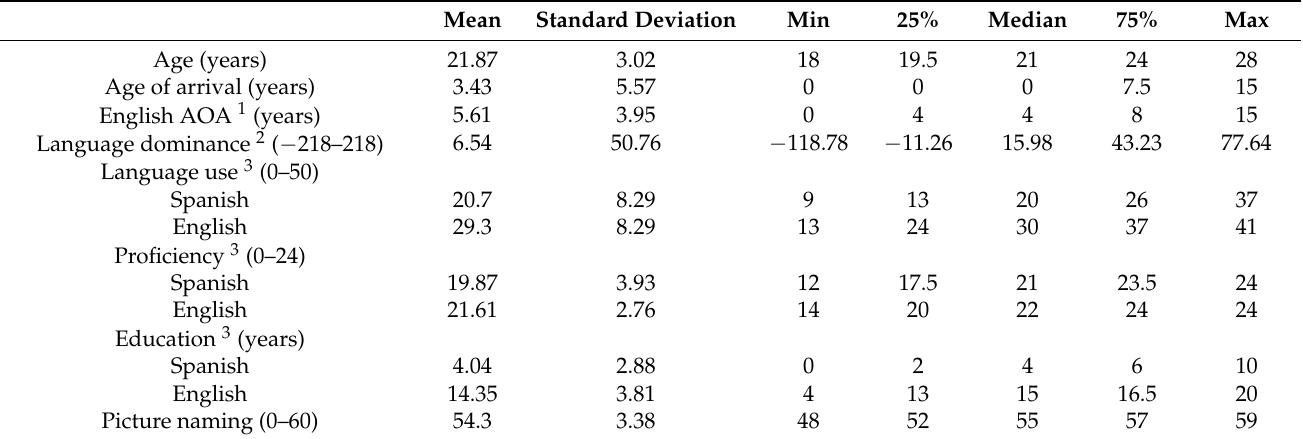
Table 1. Descriptive statistics of participants’ language